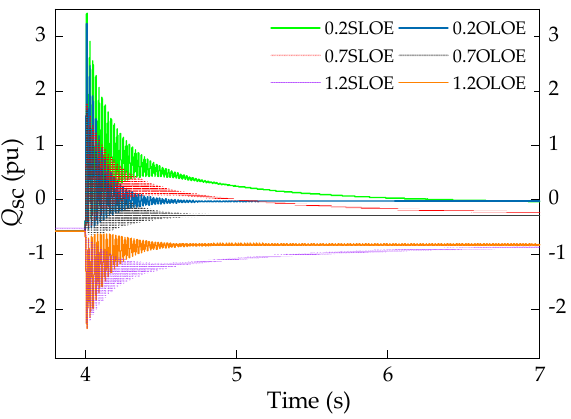
Figure 5. Reactive power response of the LOE SC when system voltage Figure 5 . Reactive power response of the LOE SC when system voltage changes.